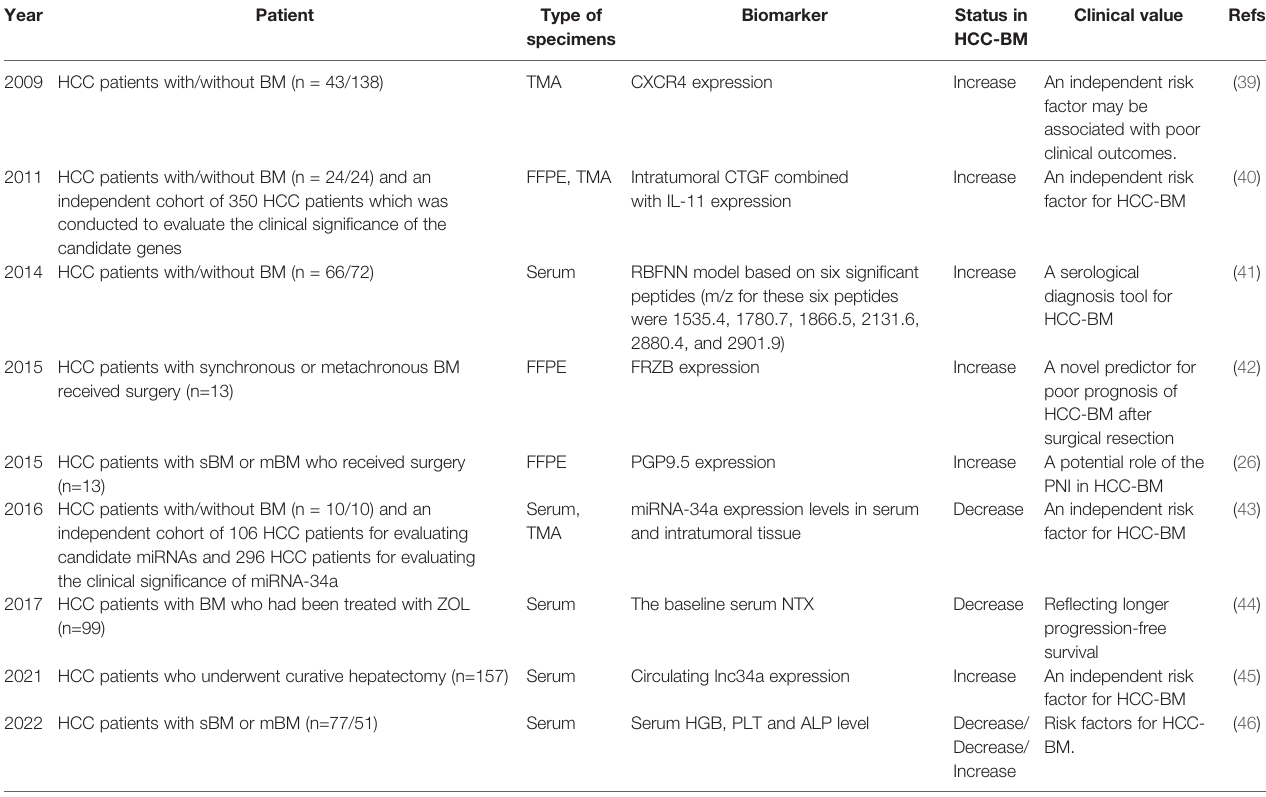
TABLE 1 | Clinical studies about molecular markers in